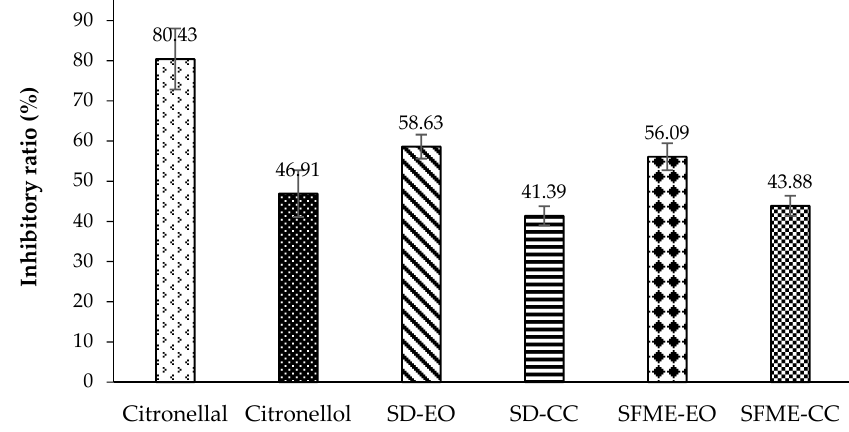
Figure 6. Tyrosinase inhibitory ratio (%) of ‘Mato Peiyu’ leaf essential oils, citronellal, and citronellol. SD-EO, SFME-EO, citronellal, and citronellol were measured at a concentration of 1.000% ( v / v ). SD-CC and SFME-CC were measured at concentrations of 0.507% and 0.598% ( v / v ) according to the composition ratios in 1.000% ( v / v ) SD-EO and SFME-EO, respectively. Data are presented as the mean ± standard deviation based on triplicate determination.